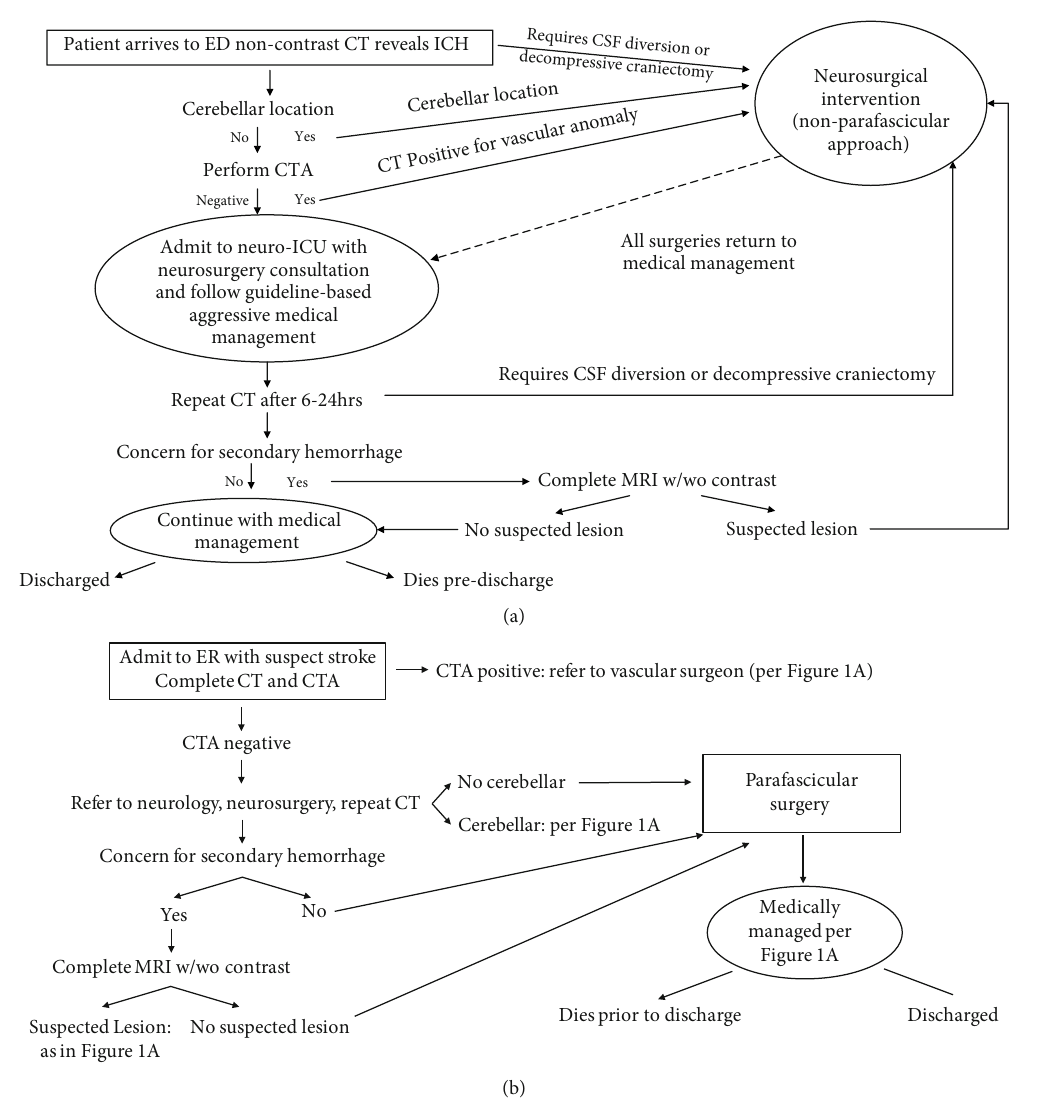
Figure 1: (a) Flow diagram of medical management of intracerebral hemorrhage (ICH) stroke patients: 2012-2013. (b) Flow diagram of